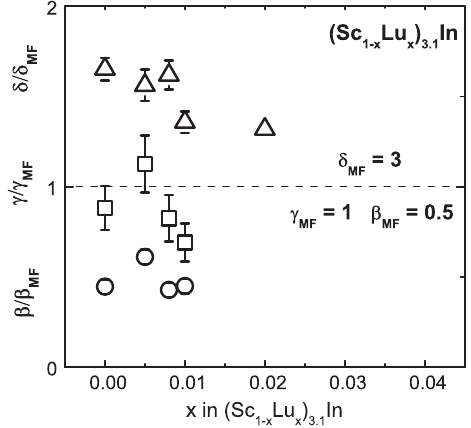
FIG. 7. The critical exponents scaled by their MF values δ = δ Þ Lu (triangles), γ = γ (squares), and β = β 3 . 1 In x x MF composition x